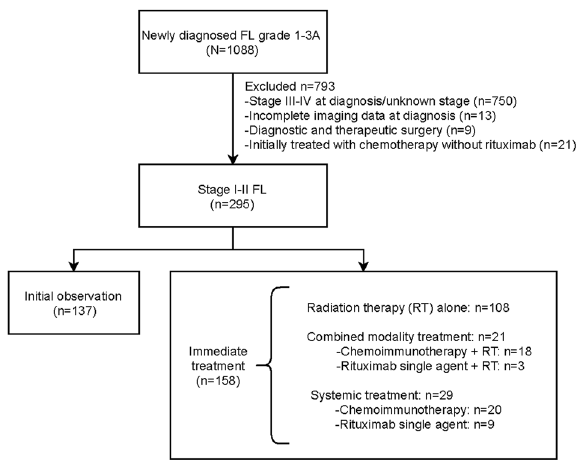
Fig. 1 CONSORT diagram of eligible patients with follicular lymphoma. Patients with grade 1 – 3 A, stage I – II follicular lymphoma (FL) diagnosed between 1998 and 2009 and managed at MSK were identi fi ed. FL follicular lymphoma, RT radiation